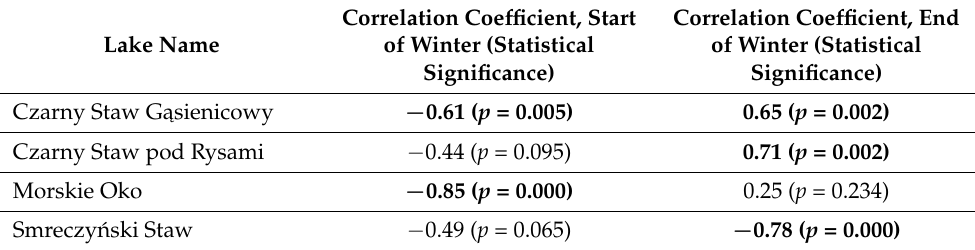
Table 4. Values of the Pearson correlation coefficient between the snow and ice thicknesses at the measuring points. Correlation Coefficient, End Correlation Coefficient, Start of Winter (Statistical Lake Name of Winter (Statistical Significance) Significance)